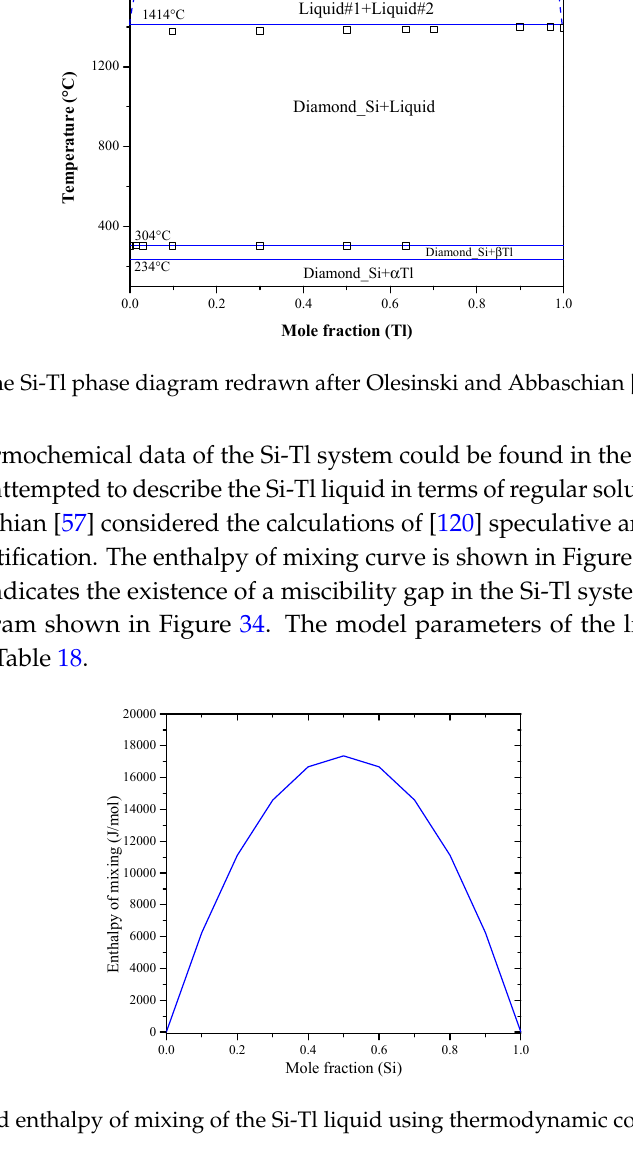
Figure 35. Calculated enthalpy of mixing of the Si-Tl liquid using thermodynamic coefficients from [120].